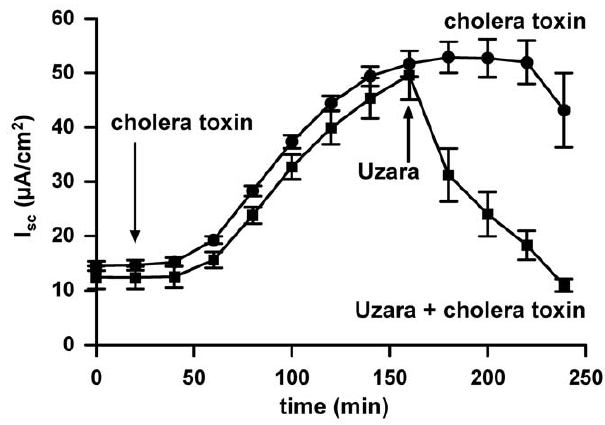
Figure 7. Inhibitory effect of Uzara on the cholera toxin- mediated I SC rise in HT-29/B6 cells. I SC was measured in HT-29/B6 cell monolayers mounted in Ussing chambers. Uzara (50 m g/ml) was applied on the basolateral side 150 min after mucosal addition of 1 m g/ ml cholera toxin. The data show that Uzara diminished also the cholera toxin-induced rise in I SC . Values are expressed as mean 6 s.e.m. (n=6).